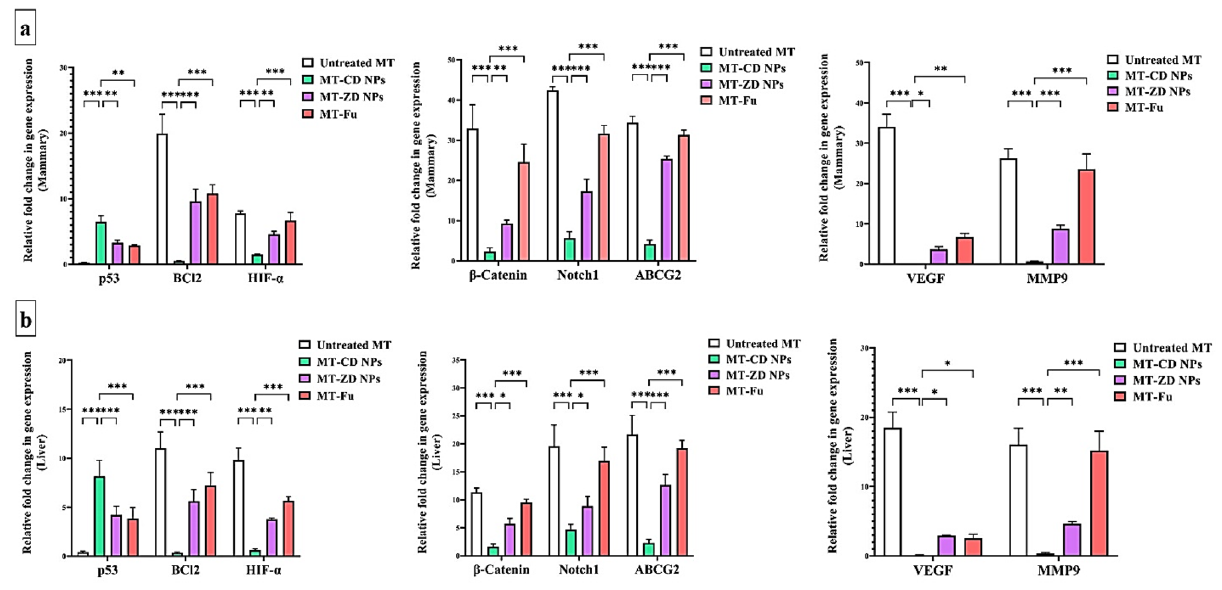
Figure 6. Regulatory impact on the expression of key apoptotic gene and oncogenes using qPCR. The relative gene expression of p53, BCl2, hypoxia-inducing factor (HIF)-α, β-catenin, Notch1, ATP Binding Cassette Subfamily G Member 2 (ABCG2), vascular endothelial growth factor (VEGF), and matrix metalloprotease (MMP)9 were quantified in ( a ) mammary tumor and ( b ) liver tissues of the untreated mammary tumor- bearing mouse group (MT), CD NPs-treated MT group (MT-CD NPs), MT-ZD NPs group, and MT-Fu group. All values are demonstrated as mean ± SEM. MT-CD NPs group was compared to other groups, considering significantly different at p < 0.05*, < 0.01**, and <